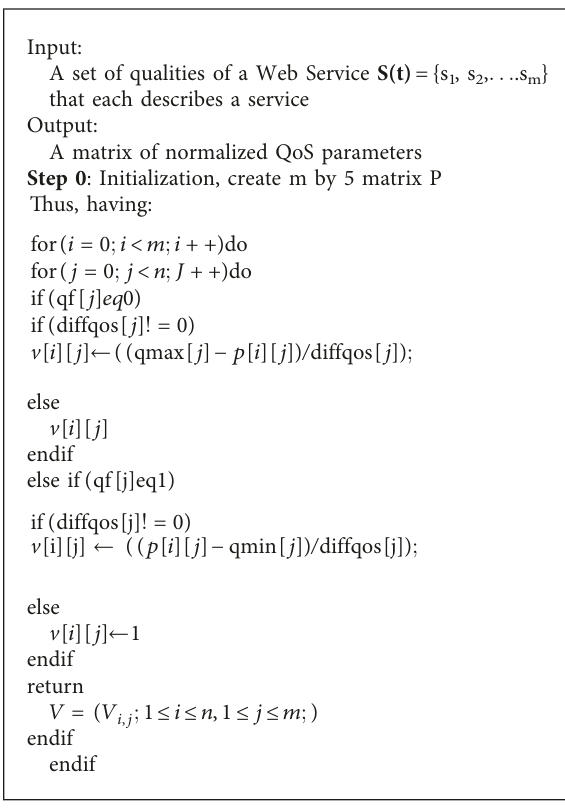
A LGORITHM 1: QoS property normalization